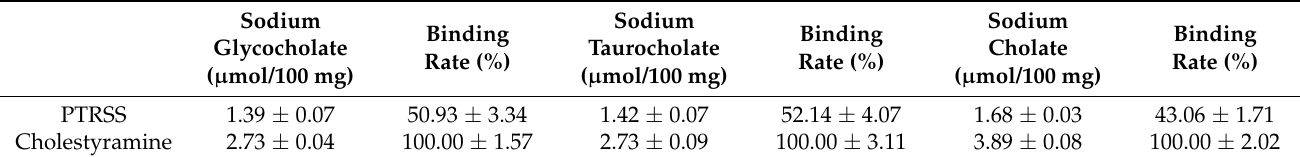
Table 1. The capacities of total triterpenoids from the sclerotia of PTRSS for binding with bile salts in vitro.